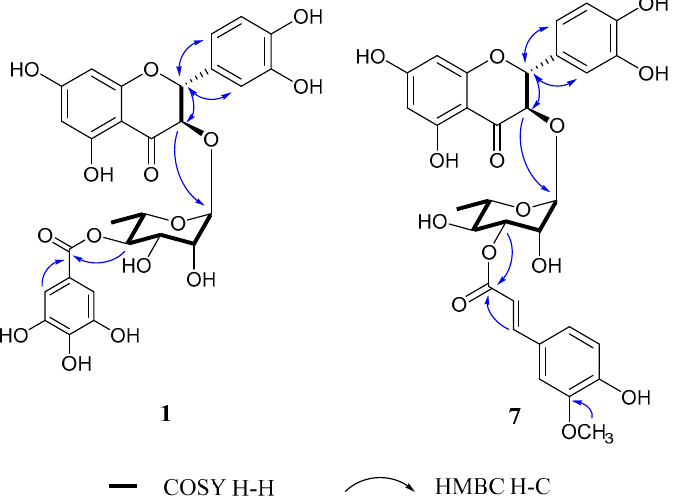
Figure 3. The key COSY and HMBC correlations of compounds 1 and 7